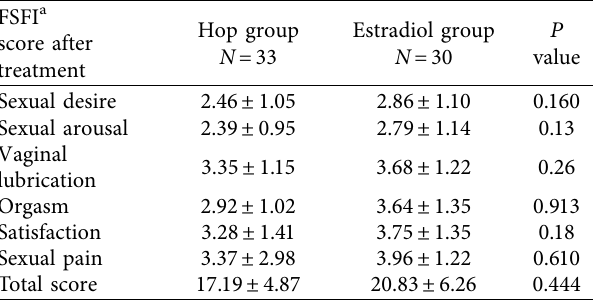
Table 3: FSFI scores of the women in the hop and estradiol groups after